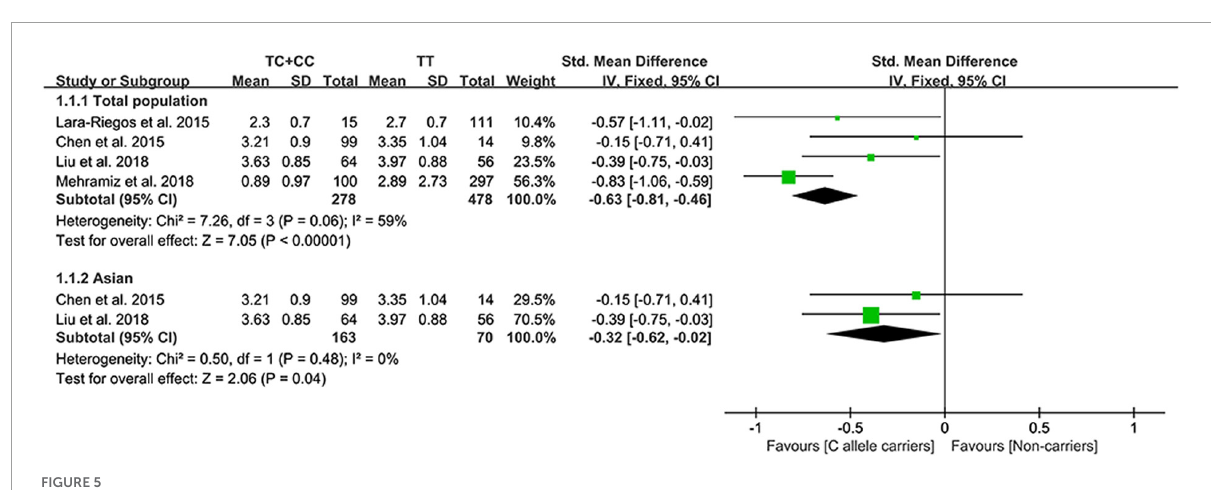
FIGURE4 A forest plot of lncRNA rs10757274 variant with circulating HDL-C levels.